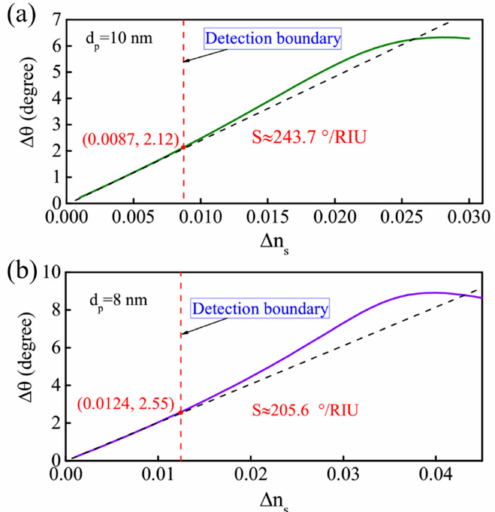
Figure 5. ( a ) The resonance signal obtained from the GWSPR biosensor at d p = 12 nm when n s ranges from 1.330 to 1.346. ( b ) The sensitivity obtained from different ∆ n s . When ∆ n s ≤ 0.005, the sensitivity can maintain a stable value.